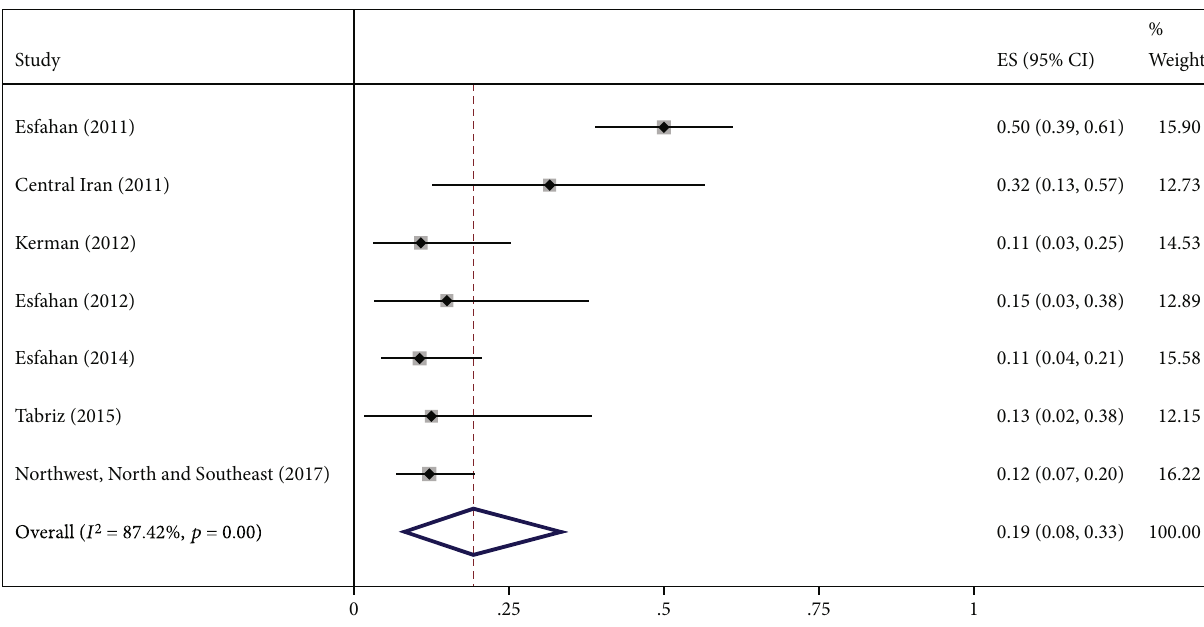
Figure 7: Forest plot of 7 studies on cystic echinococcosis G